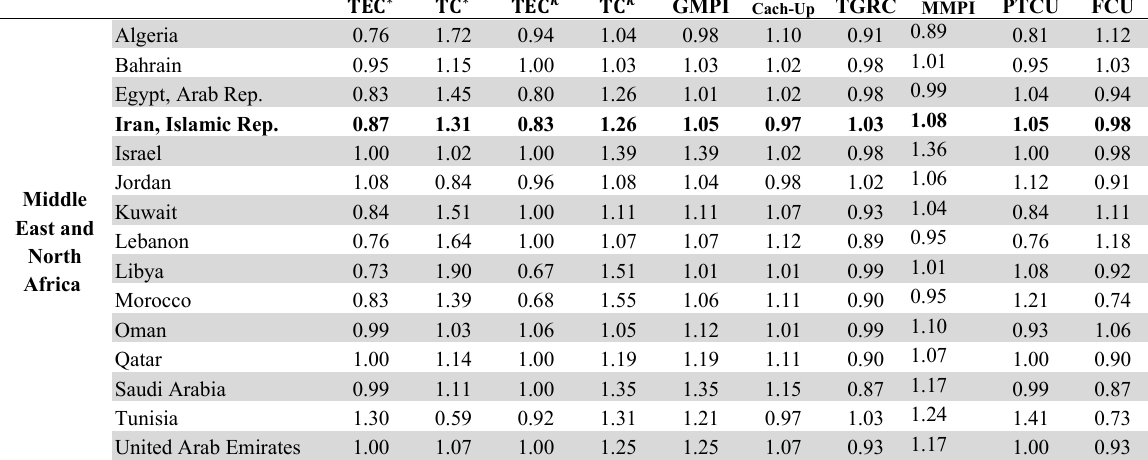
Calculations of productivity changes using the metafrontier Malmquist method for Middle East and North Africa